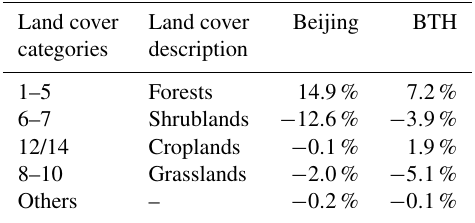
Figure 2. Land cover change from 2001 to 2013. Spatial distribu- tions of (a) forests, (b) shrublands, (c) croplands, and (d) grass- lands. Table 2. Land cover change over Beijing and BTH from 2001 to